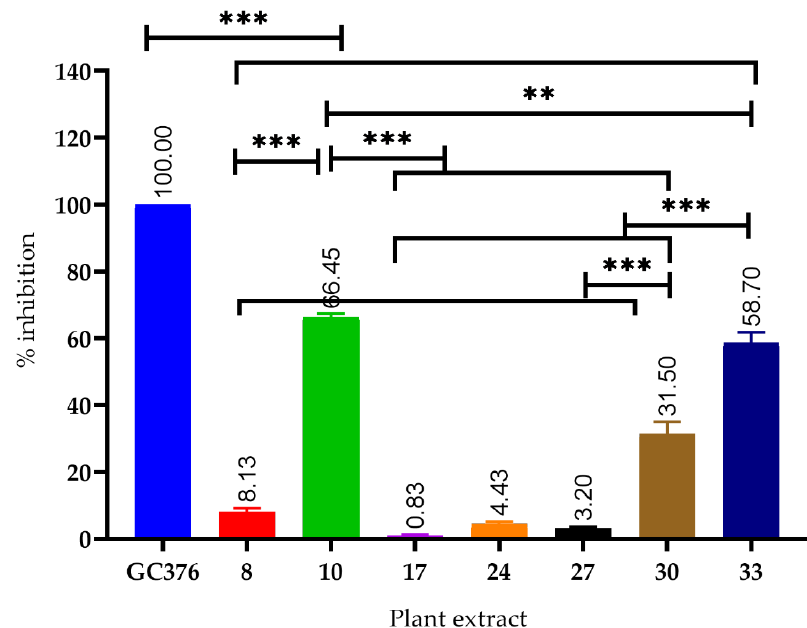
Figure 1. Plant extracts with significant inhibitory activity against the viral protease (SARS-CoV-2 M PRO ) GC376; positive control, *** significantly different at p < 0.0001, ** significantly different at p <